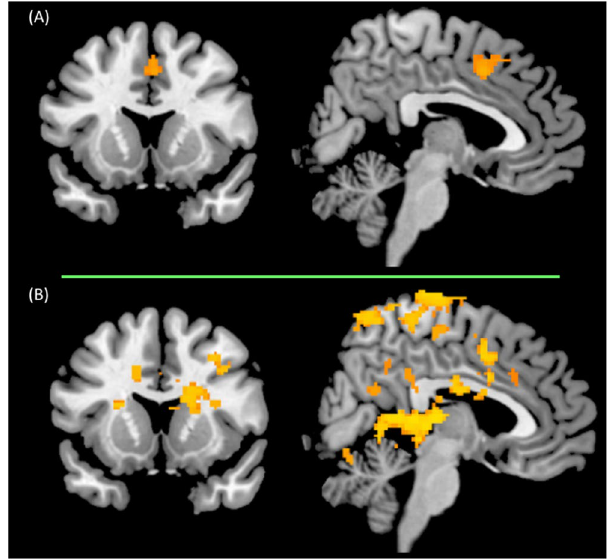
Figure 3. ( A ) Higher dorsal anterior cingulate activation (MNI coordinates: x = 4, y = 12, z = 44) during reactive inhibition (i.e., successful minus unsuccessful stop) in poker players, as compared to controls. (B) Higher brain activation in poker players, as compared to controls, for the successful stop minus baseline contrast. These contrast maps were thresholded using TFCE with p < 0.05, corrected for multiple comparisons across the whole